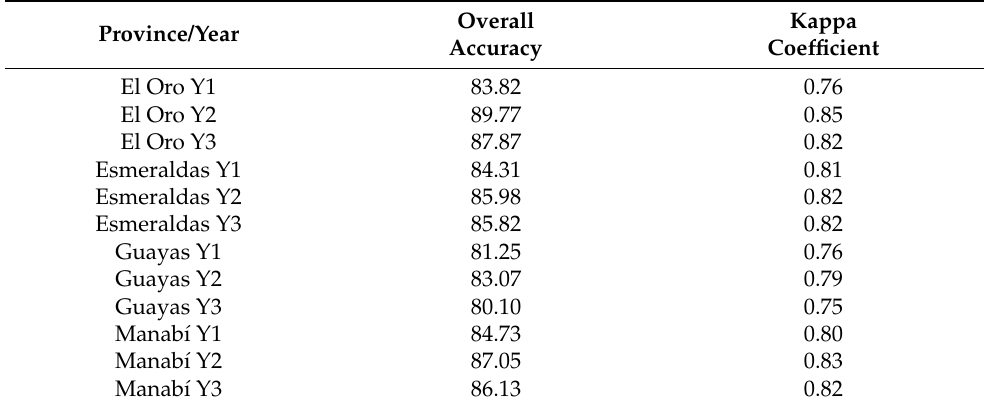
Table 5. Accuracy assessment and kappa coefficient